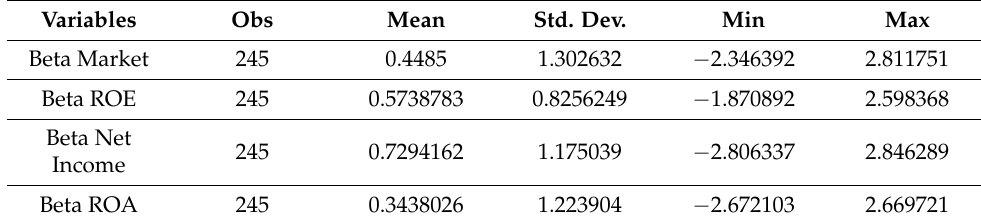
Table 2. Descriptive statistics.